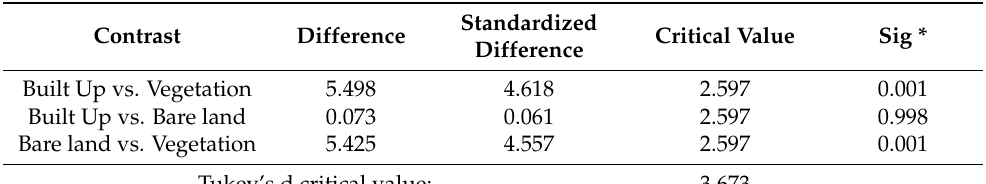
Table 4. Results of Tukey HSD paired comparisons to investigate the significance of LST difference between the studied land use classes (1987–2019).